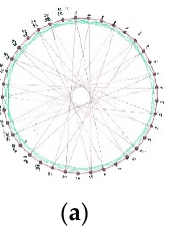
( b ) Figure 8. Counting strategies. Drawing made by participant: ( a ) A6; ( b ) A1. As shown in Figure 8, participants A6 and A1 use graphs to count the number of high fives, counting the edges between points in cases where the number of people is small. When they realize that every person greets the number of people minus one (participant A1 even writes it) they employ an inductive counting strategy. Participant A1 needs some help to perform the computations and finally uses a calculator. Participant A5 uses induction but finds a wrong pattern, adding all the numbers from the given number of people until 1. The other participants give some correct answers, but